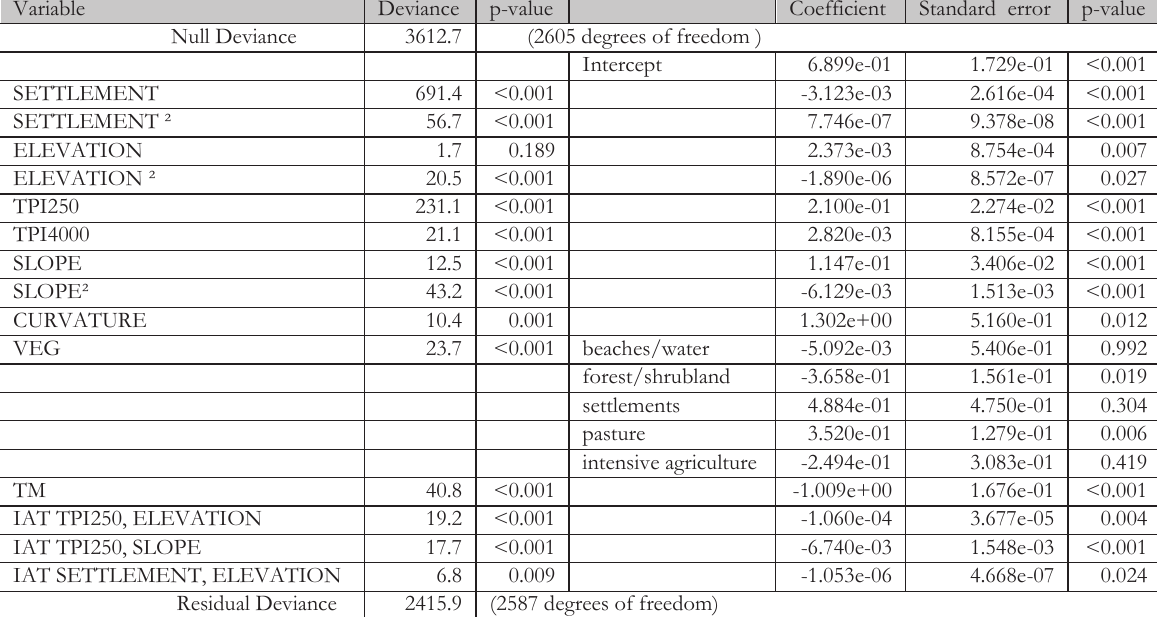
Table 2: Variables of the final model.